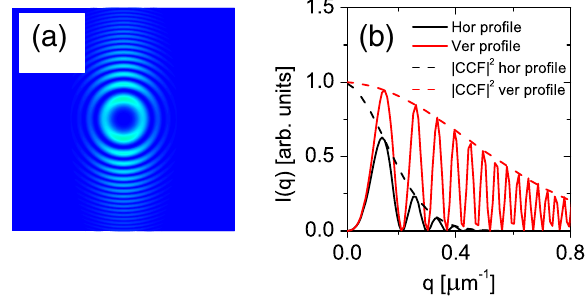
FIG. 3. (a) Simulated 2-D power spectrum I ð ⃗ q Þ of heterodyne speckles and (b) radial profiles along the horizontal (solid black line) and vertical direction (solid red line), showing Talbot oscillations enveloped by the radiation CCF. Here q ¼ j ⃗ q j . Simulation parameters are λ ¼ 440 nm and z ¼ 2 mm. A 2-D Gaussian coherence factor of the form exp ð − x 2 = σ 2 exp ð − y 2 = σ 2 Þ has been used, with σ coh ; x ¼ 30 μ m and coh ; y σ 90 μ m. A flat particle form factor S ð q Þ and response coh ; y ¼ function H ð q Þ have been assumed for simplicity.